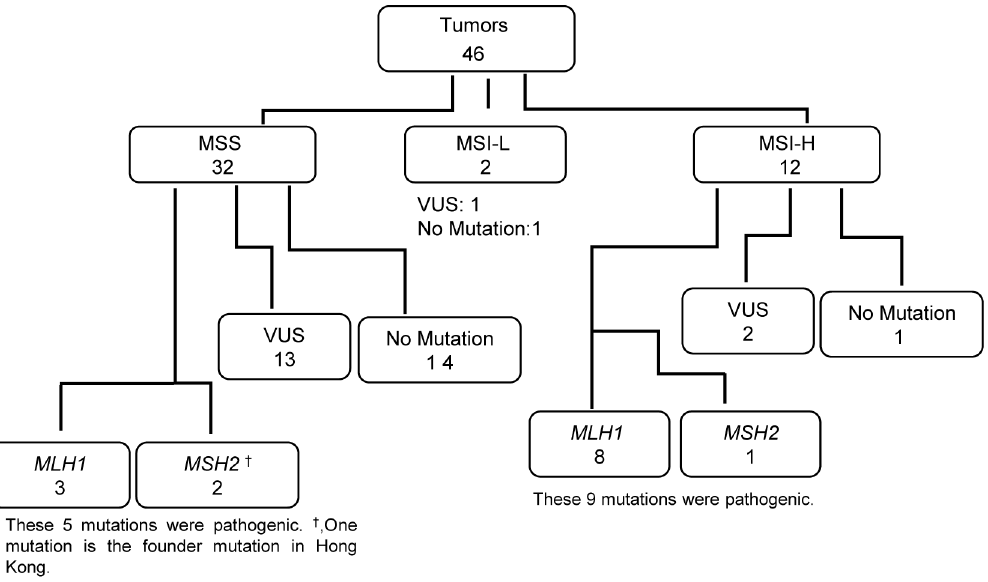
Figure 3. Correlation between tumor MSI status and germline mutations. Number in each box, case numeration. VUS, variant with uncertain significance.